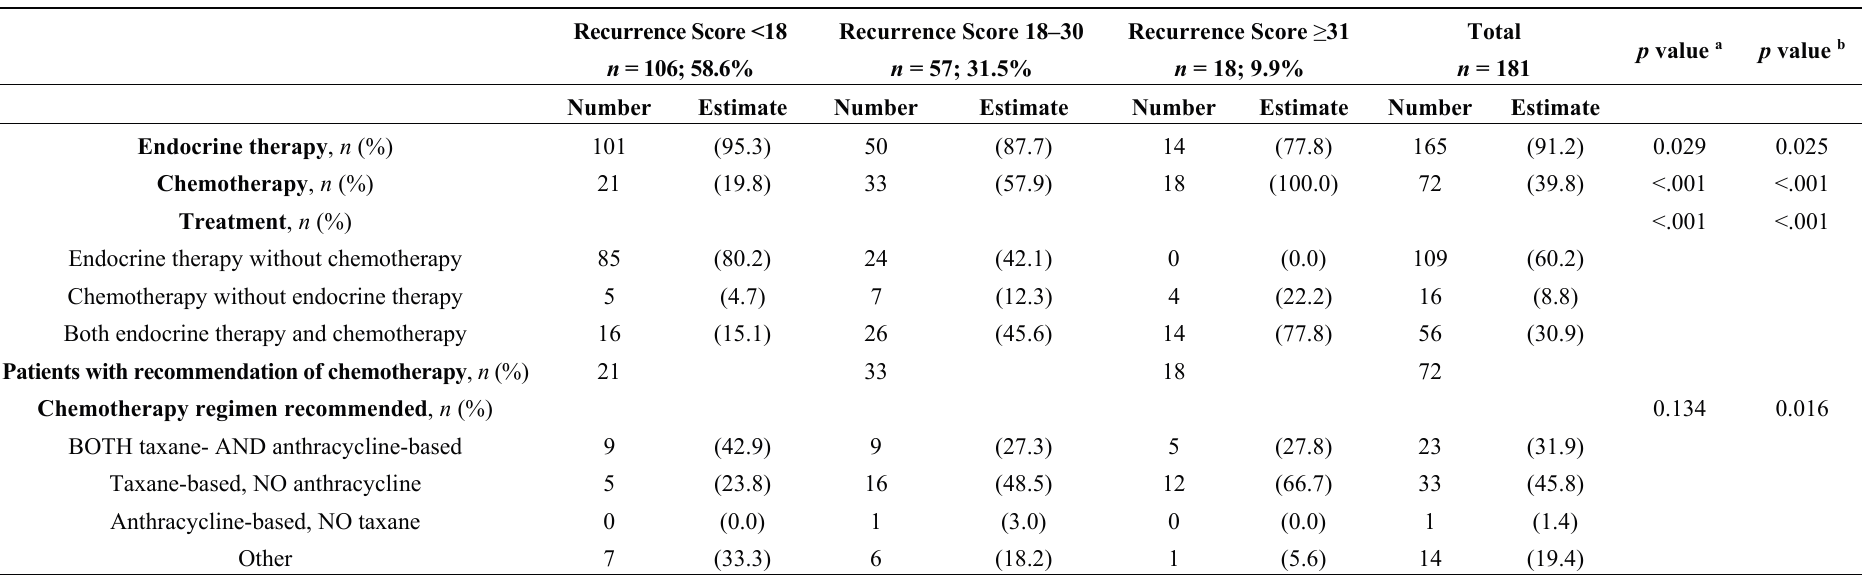
Table 3. Adjuvant treatment recommendations by Onco type DX Recurrence Score